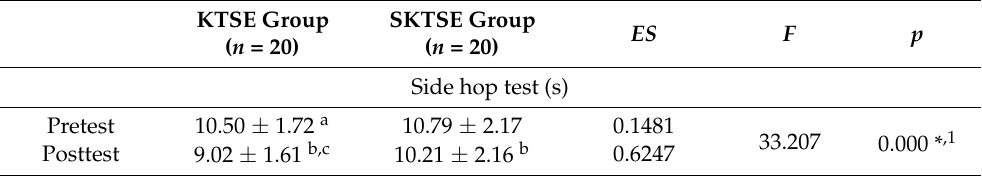
Table 5. Comparison of side hop test between the KTSE and SKTSE groups. KTSE Group SKTSE Group ES F p ( n = 20) ( n = 20) Side hop test (s) Pretest 10.50 ± 1.72 a 10.79 ± 2.17 0.1481 33.207 0.000 * ,1 Posttest 9.02 ± 1.61 b,c 10.21 ± 2.16